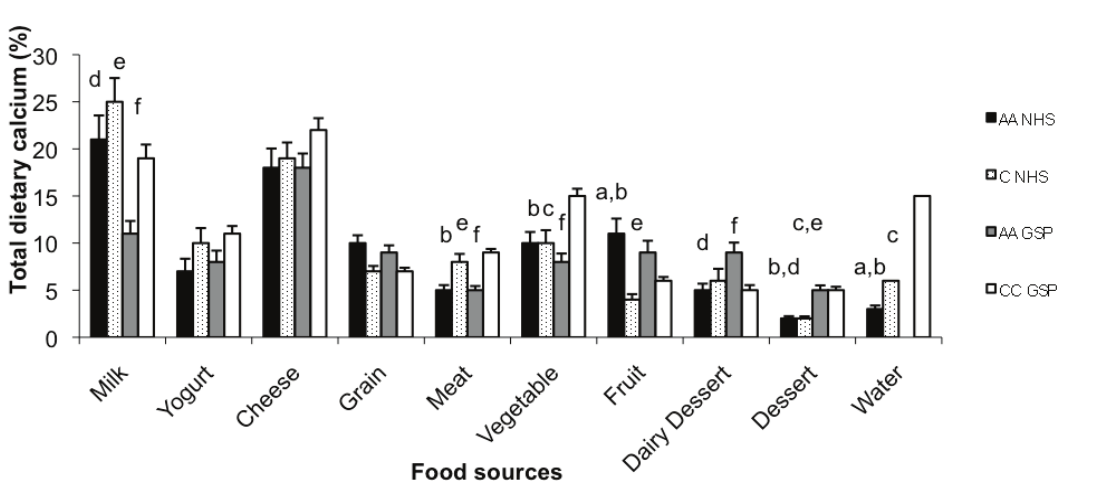
Figure 1. Percentage of total dietary calcium (X ± SE) from various food sources among the Nutrition-Health Students (NHS) and General-Student Populations (GSP). AA = African Americans, C = Caucasian American, CC = Caucasian Croatian. Water includes mineral water for Croatian population only; a African American NHS differ significantly from Caucasian American NHS, b African American NHS differ significantly from Croatian students, c Caucasian American NHS differ significantly from Croatian students, d African American GSP students differ significantly from African American NHS, e African American GSP students differ significantly from Caucasian American NHS, f African American GSP students differ significantly from Croatian students.